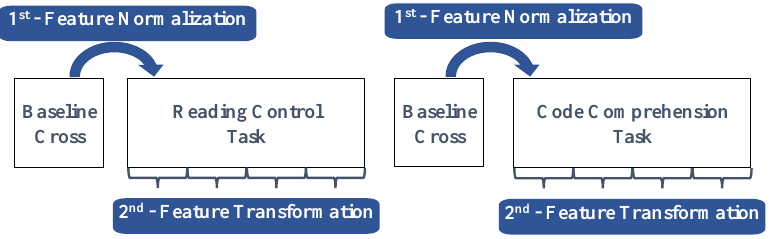
Figure 5. Schematic representation of the feature normalization and transformation